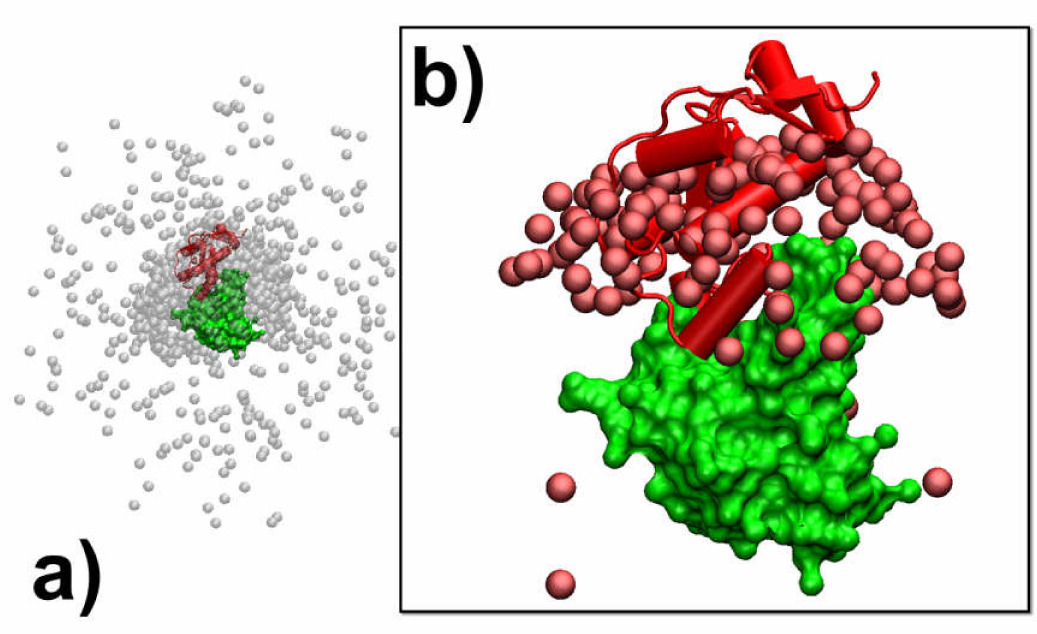
Figure 5. We plotted the spatial distribution of 10 3 randomly selected final configurations from all the 10 4 simulation trajectories of protein complex 2VLN. In ( a ), the native structure of the protein complex is placed in the center of the box, while the protein E9 DNase domain is shown in green with its surface profile and Im9 is shown in red in the cartoon representation. The structures of protein E9 DNase domain from our simulations were aligned with the native configuration, while the centers of mass for their corresponding protein Im9 are represented by the grey points. In ( b ), we further plotted the spatial distribution of those configurations in which encounter complexes were successfully formed. The centers of mass for the protein Im9 in these configurations are represented by the red